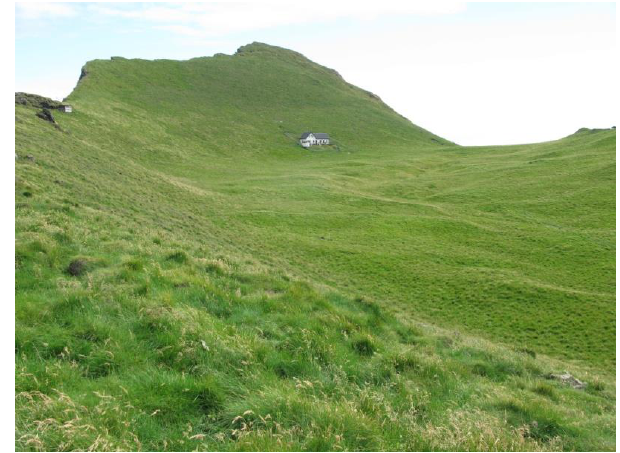
Figure 10. Festuca rubra/Poa pratensis grassland on upper parts of Elliðaey. Plot E1 was located in a puffin colony on the palagoninte ridge above and to the right of the cottage. Photo: BM,